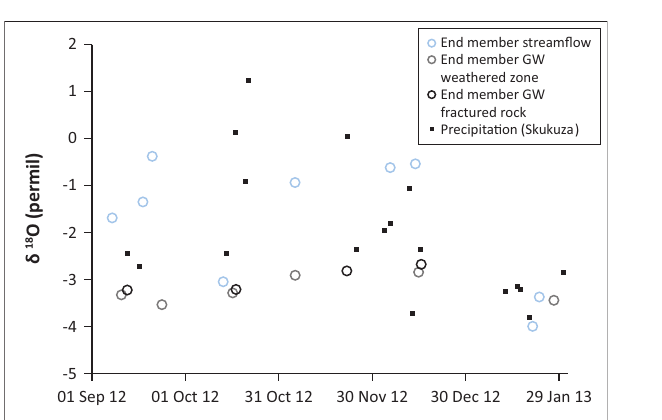
FIGURE 4: Flow duration curve for the three different order catchment outlets (SGR 1, SGR 2, SGR 3) September 2012–April 2013.